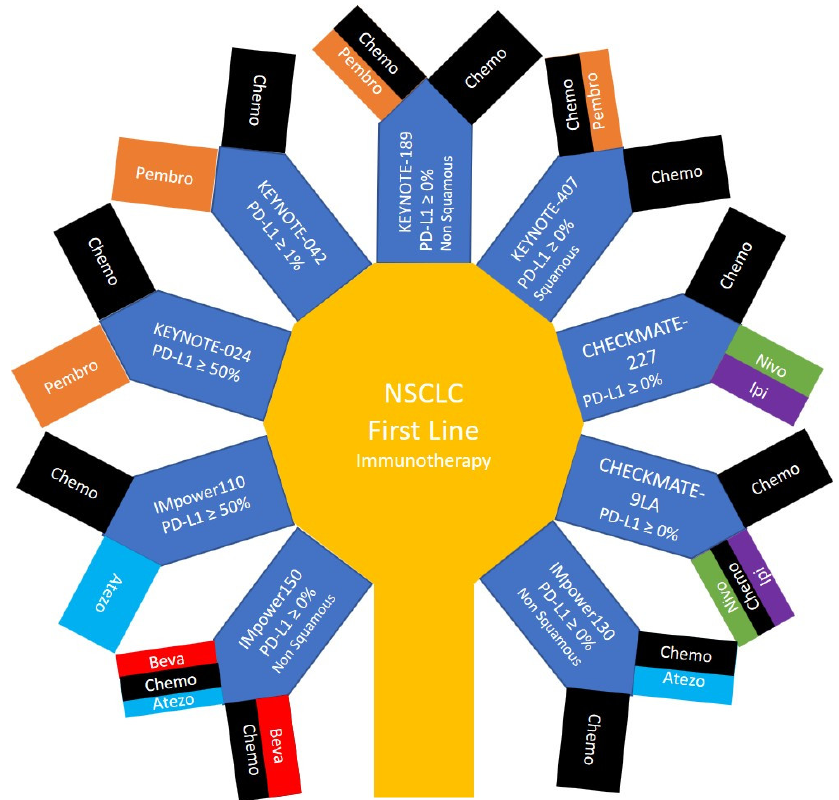
Figure 2. The main treatment arms of phase 3 clinical trials providing immunotherapy in the first line for patients with non-small cell lung cancer. Pharmaceuticals 2020 , 13 , x FOR PEER REVIEW